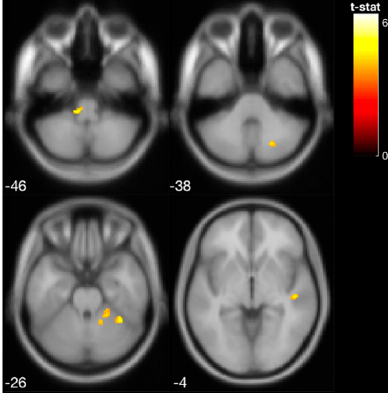
Figure 3. Statistical analysis of clinical balance test outcome metrics (* indicates significant differ- ences with respect to the pre-training assessment regardless of group; † indicates significant differ- ences between the two groups). Error bars represent the standard errors of the means. Only the clinical balance test outcome metrics with significant changes are shown; the complete results can be found in Appendix A. ( a ) SOT Composite: Sensory Organization Test Composite Score; ( b ) Ves- tibular Reliance calculated from the SOT; ( c ) Mini-BESTest28: Mini Balance Evaluations Systems